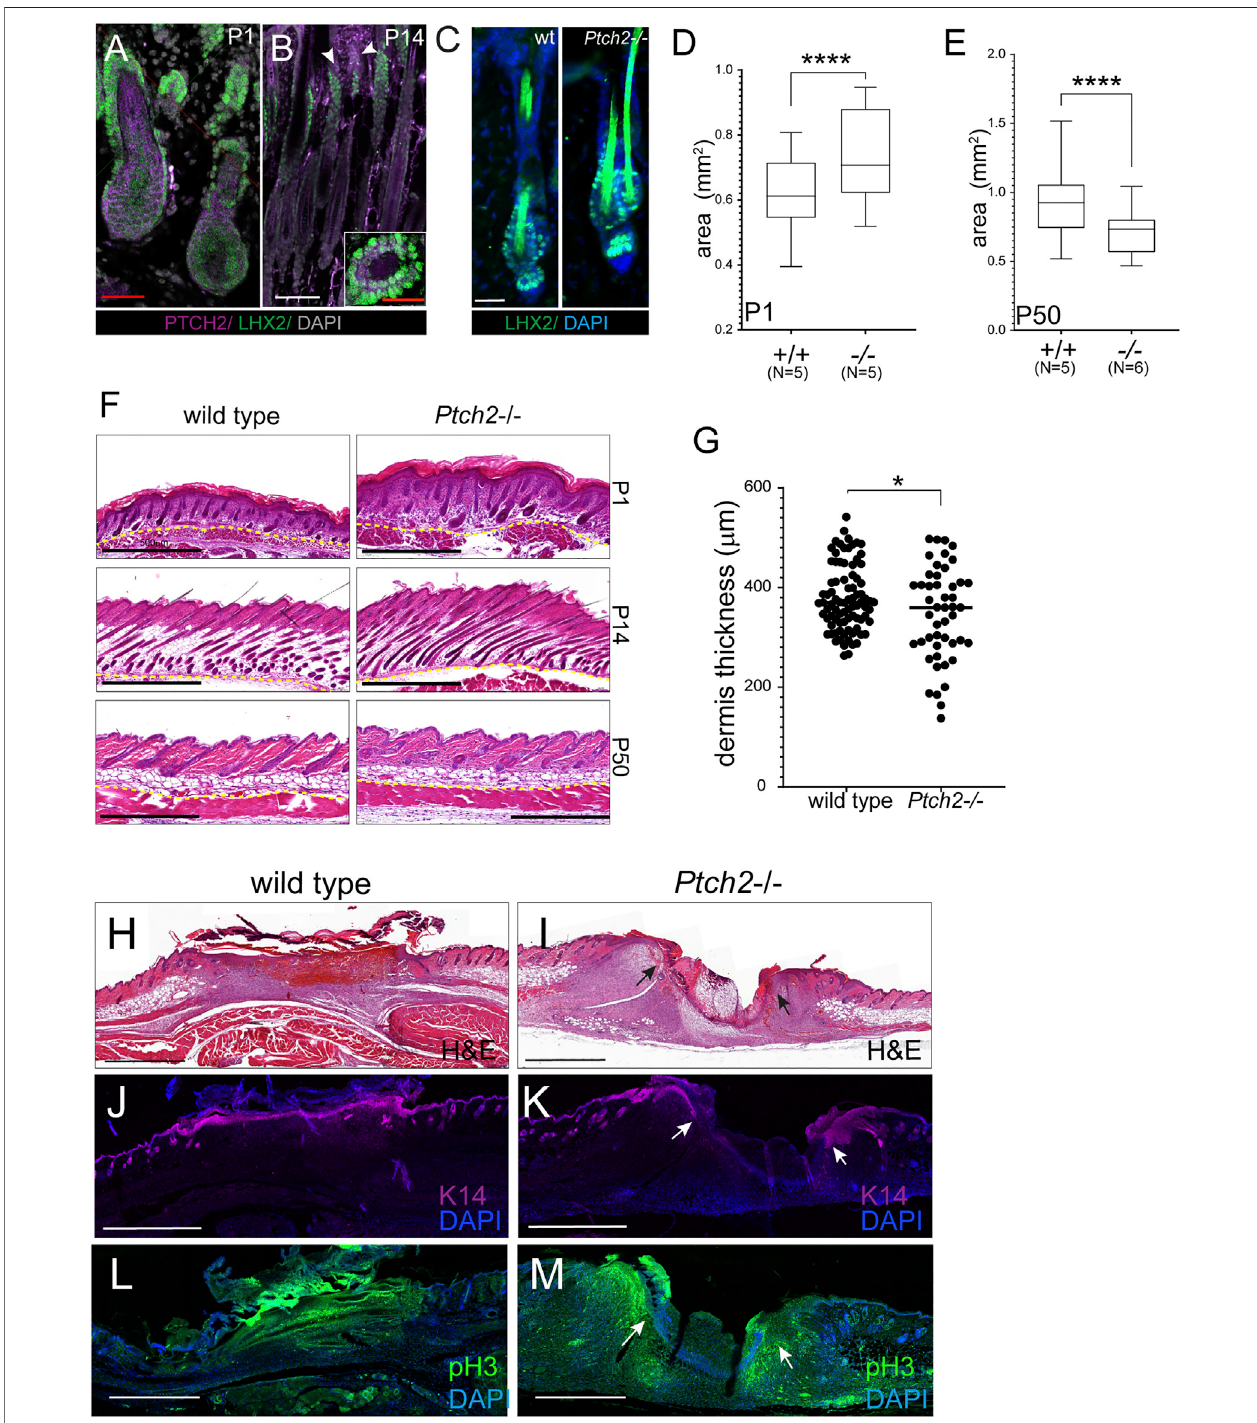
FIGURE 3 | Effects ofPtch2 abrogation on skin thickness and wound healing. (A, B) Immuno fl uorescence staining for Ptch2 (purple) and Lhx2 (green) in wild-type sections of P1 (A) , P14 (B) . White arrowheads indicate Ptch2 expression. Inset in (B) is a cross-section through P50 hair follicle processed with Lxh2 and Ptch2 immunostaining. (C) Immuno fl uorescence staining for Lhx2 (green) in adult (P50) wild-type and Ptch2 − / − skin. (D, E) Quantitative analysis of skin thickness in wild-type and Ptch2 − / − at P1 and P50. (F) H&E staining of paraf fi n sectioned skins obtained from wild-type and Ptch2 − / − mice at indicated time points. (G) Quantitative analysis of dermis thickness in wild-type and Ptch2 -/ . Scale bar red = 50 μ m, white = 100 μ m, black = 0.5 mm, **** p < 0.0001. (H – M) H&E staining (H,I) and immuno fl uorescenceagainstKeratin14 (J,K) andpHH3 (L,M) ofsectionedwild-typeand Ptch2 − / − skinwoundsatday7post-wounding.Scalebars(blackandwhite)= 0.5 mm. Arrows indicate wound edges in the Ptch2 − / − wounds.